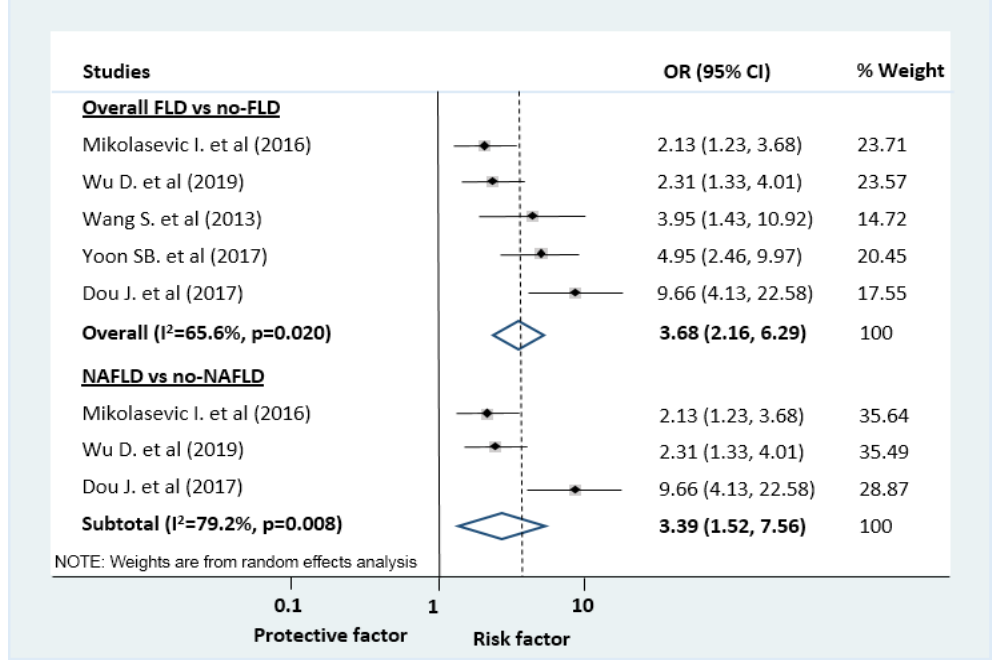
Figure 4. Forest plots of studies evaluating the association between fatty liver disease (FLD) or non-alcoholic fatty liver disease (NAFLD) and disease severity of acute pancreatitis (AP). Logistic regression analysis results were pooled, comparing the odds of moderately severe/severe vs mild AP in patients with and without FLD/ NAFLD; CI: confidence interval, OR: odds ratio.